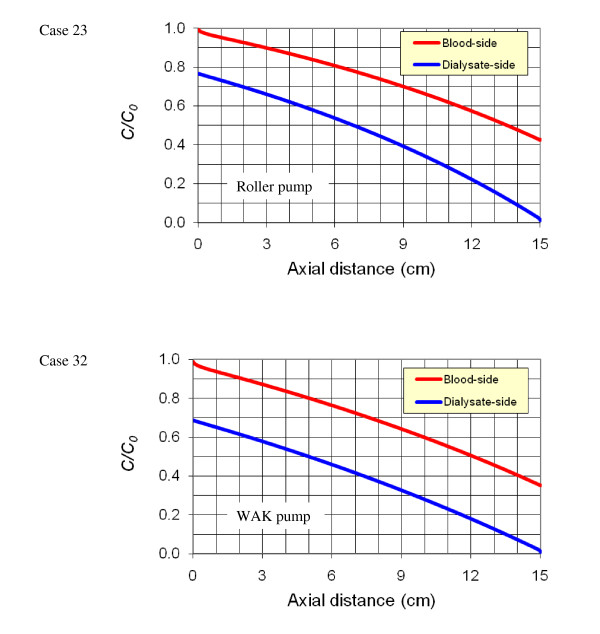
Comparison of the distribution of the relative urea concentration along the two edges of the membrane for the roller pump versus the WAK pump (computational results. The use of the WAK pump resulted in approximately 20% more urea removal than the roller pump.